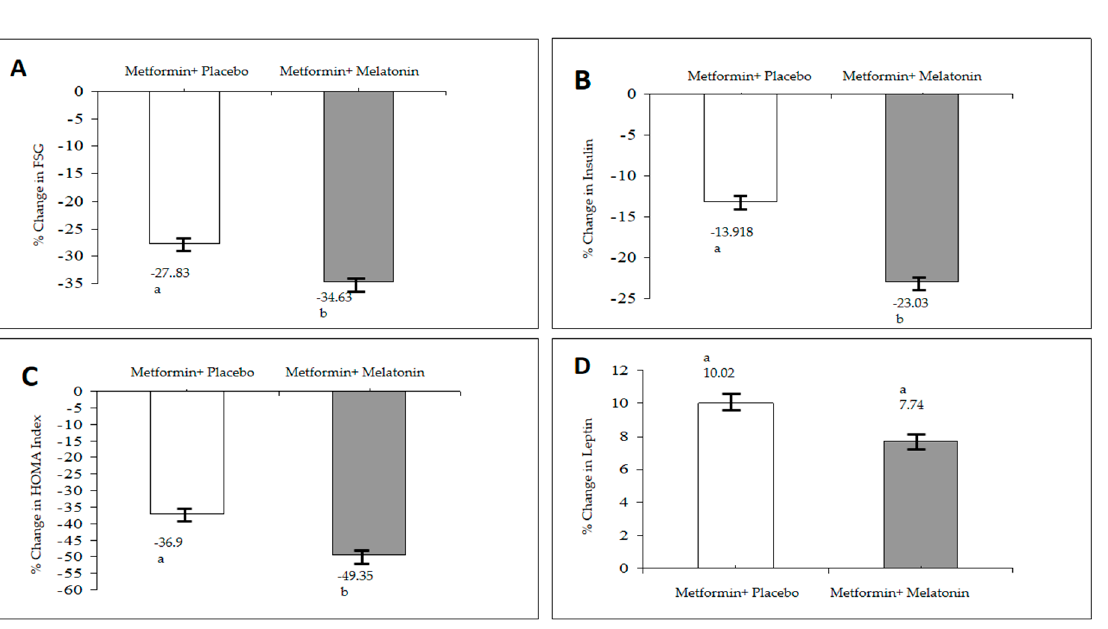
Figure 2. Comparison between the effects of metformin and placebo with metformin–melatonin on FSG ( A ), insulin ( B ), insulin resistance index ( C ) and on serum leptin ( D ) level in MEBS patients after 90 days of treatment; (a, b) significantly different ( p < 0.05), (a, a) nonsignificantly different ( p > 0.05). FSG: fasting serum glucose.